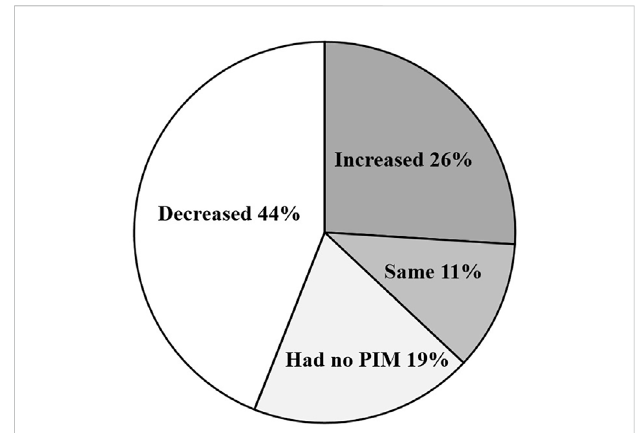
FIGURE 3 Change in the number of PIM between hospitalization and discharge. There were 44% patients had less potentially inappropriate medication (PIM) at discharge than hospitalization, 26% patients had more PIM than hospitalization at discharge; 19% patients had no PIM during hospitalization nor at discharge; 11% had the same PIM at release as in